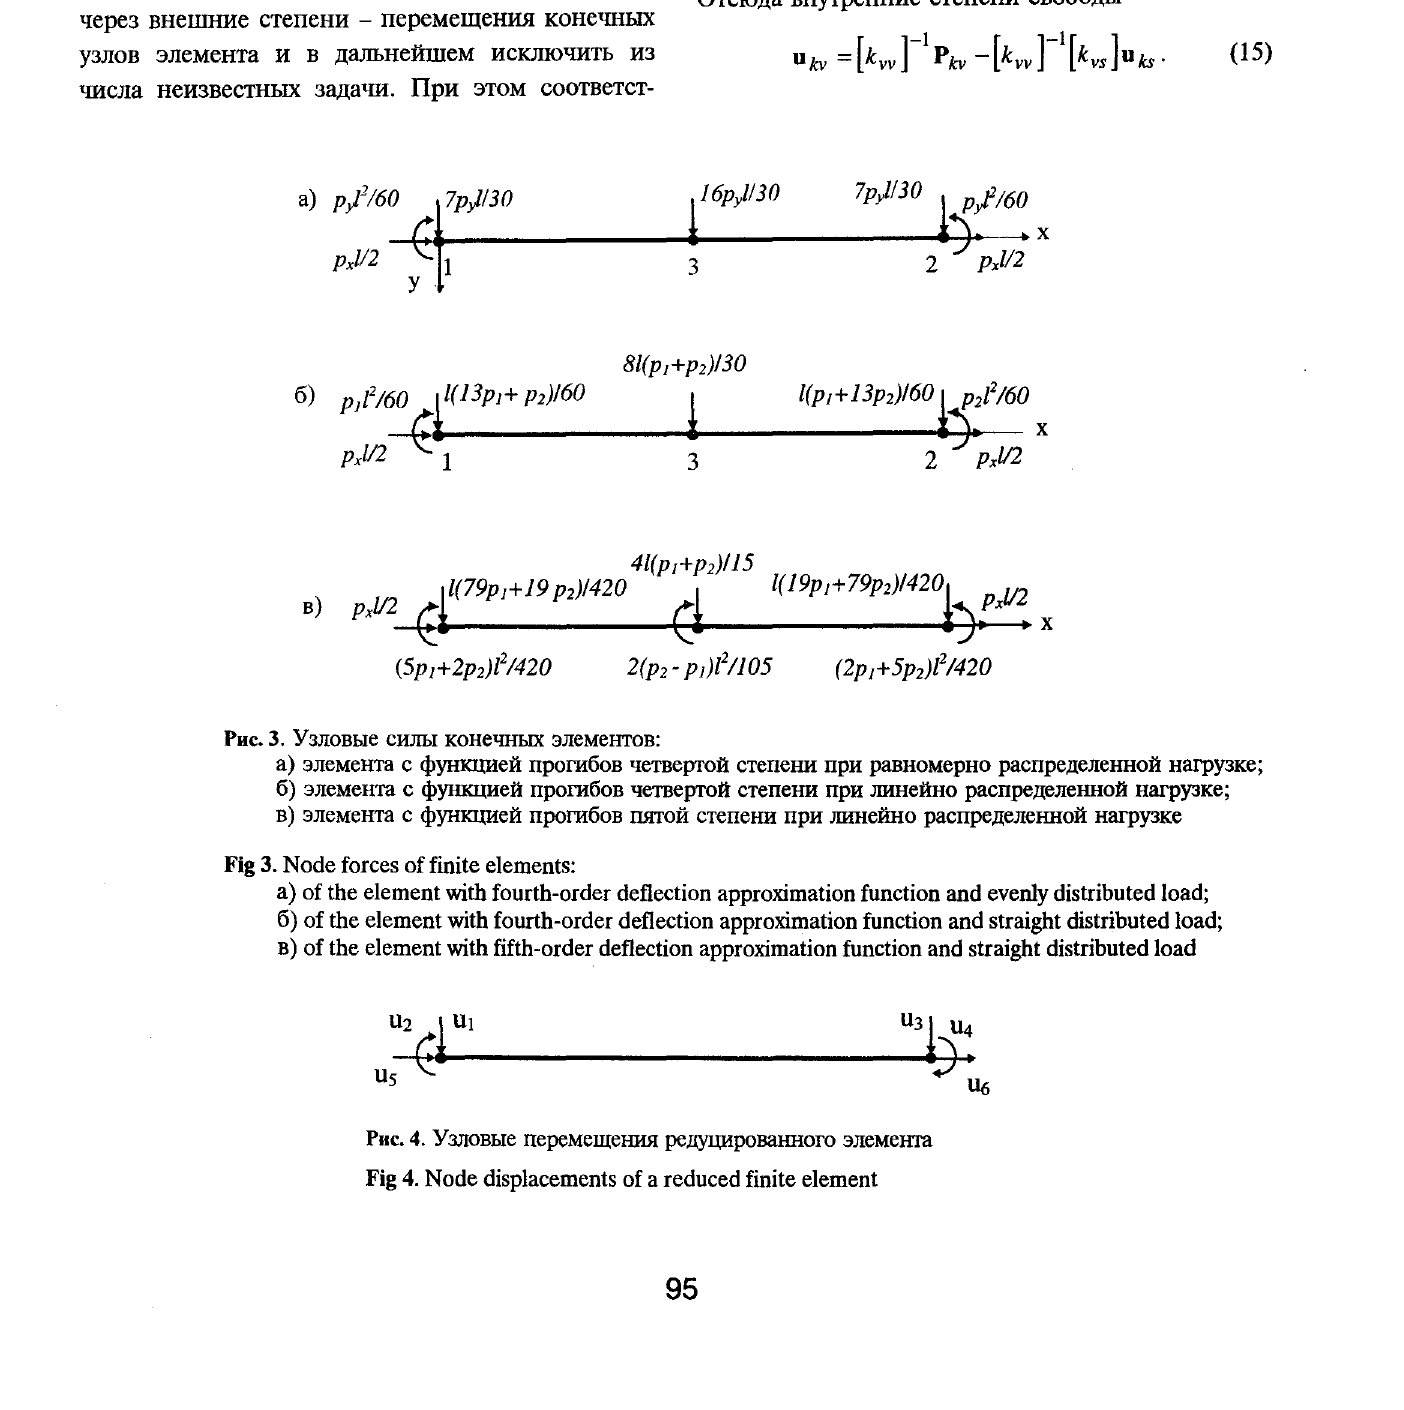
Fig 4. Node displacements of a reduced finite element